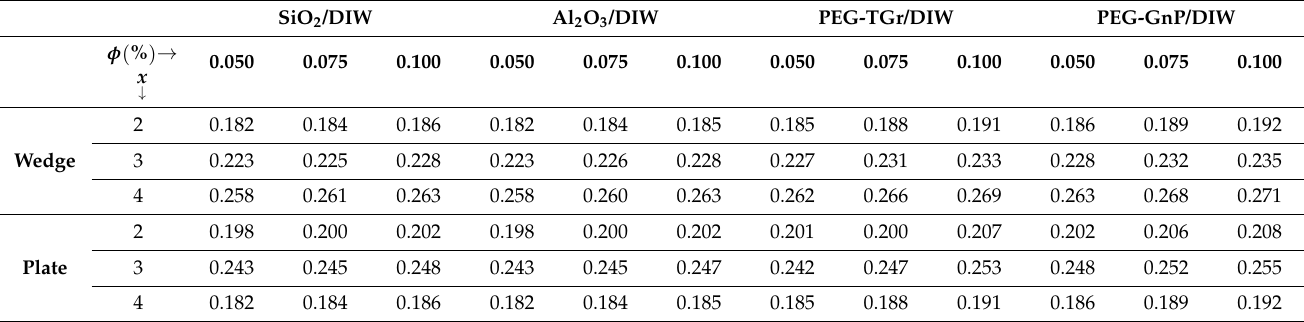
Table 10. The thermal boundary layer thickness 10 × δ T of schematic nanofluids over the wedge and plate at different nanoparticle volume